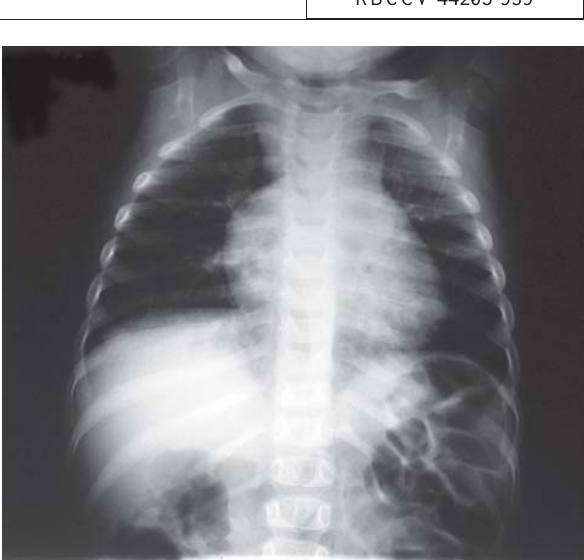
Fig. 1 – Radiografia de tórax com aumento de área cardíaca à custa de átrio